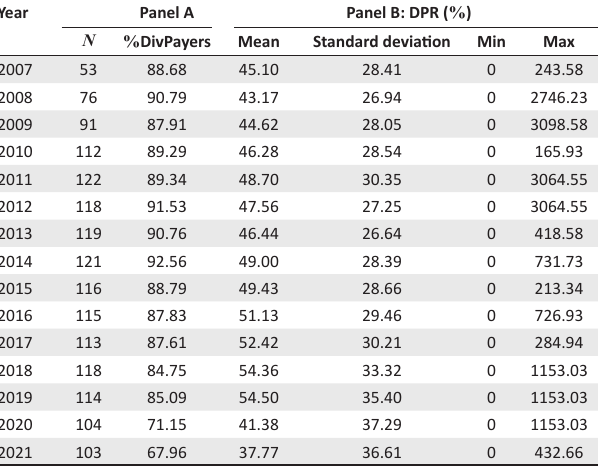
TABLE 3: Descriptive statistics for dividend distributions per